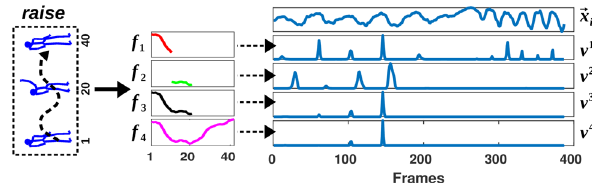
Fig. 3 Abstract filters { 𝐟 4 , 𝐟 3 } result in sparse alignment maps { v 4 , v 3 } , and 𝐟 4 can be interpreted as the representative of a complete arm movement in the raise